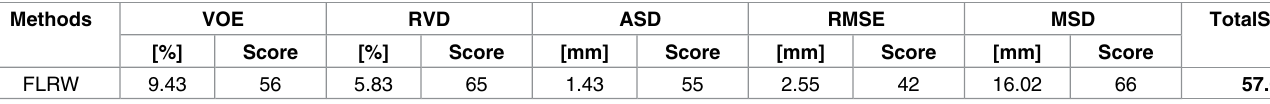
Table 6. The scores of FLRW with clinical cirrhosis database.